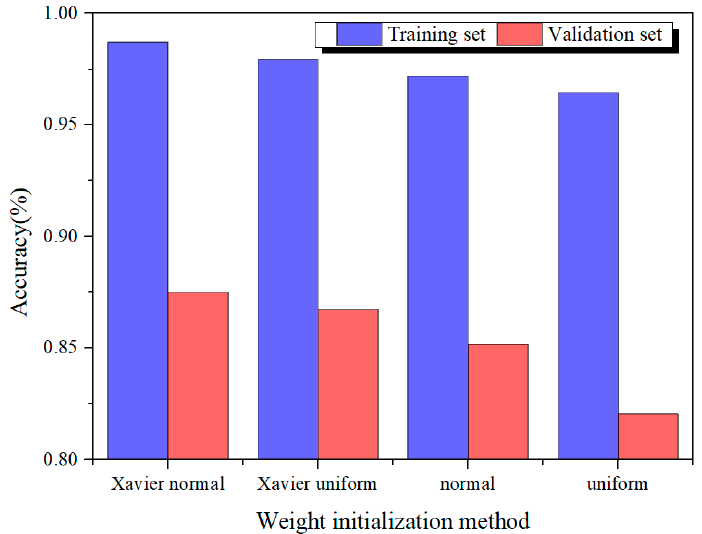
Figure 8. Comparison results of CNN on training set and validation set under different initialization methods.